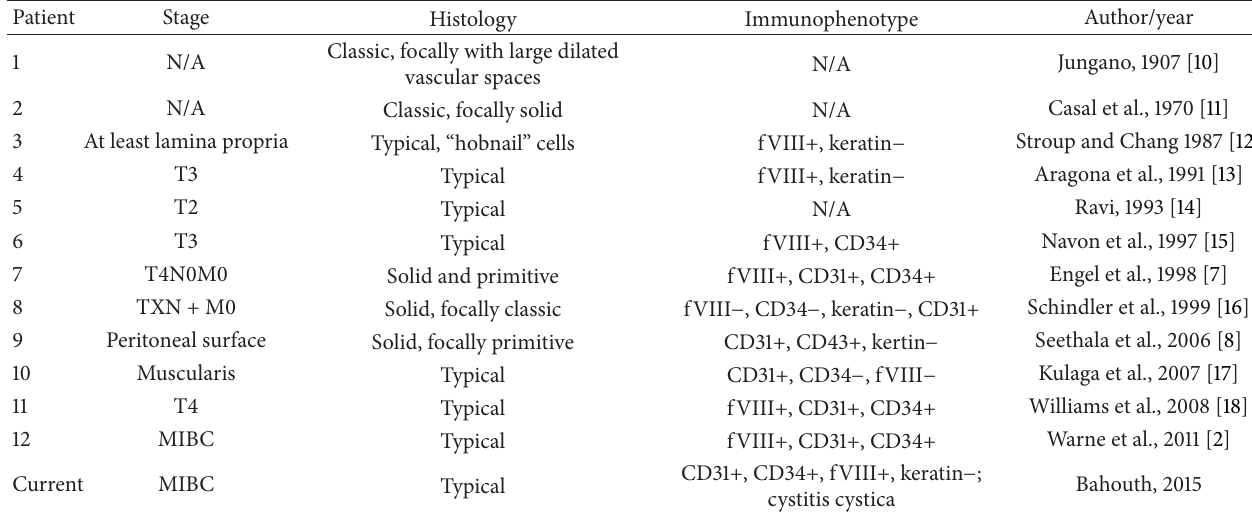
Table 2: Histopathology and immunohistochemistry of all patients